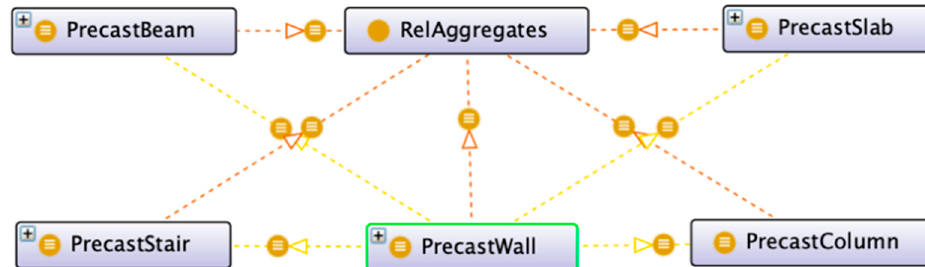
Figure 13. Relationship between the RelAggregates class and its neighborhood class.